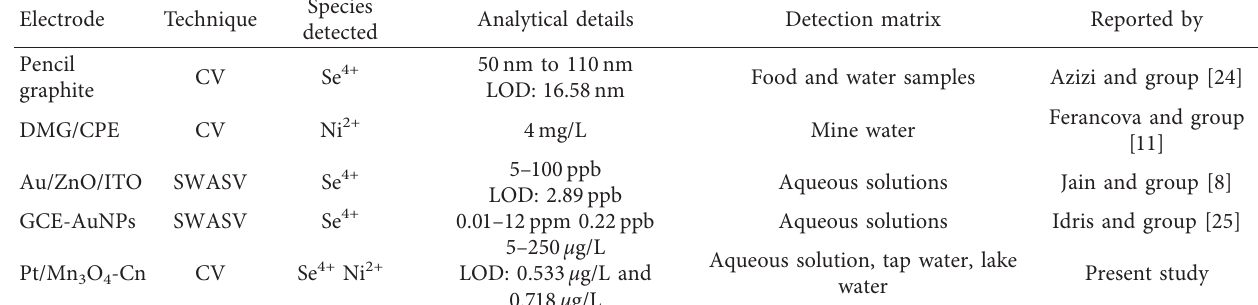
Table 1: Comparison of analytical performances of reported electrodes for Se (IV) and Ni (II) sensing.